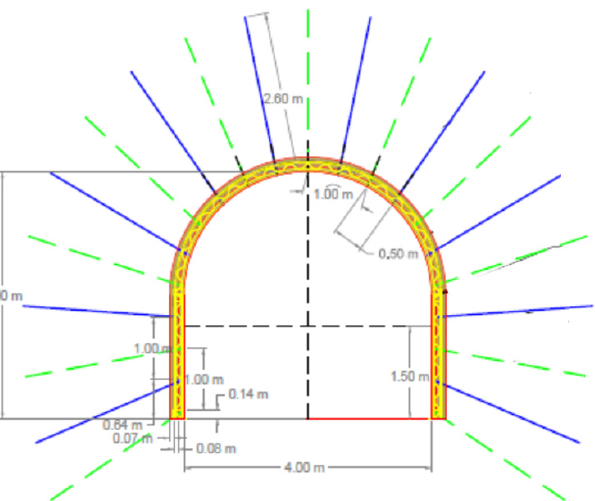
Figure 2. Example of drift support used in Papomono mine, including Helical bolts (blue), Shotcrete (red), and frames (yellow).